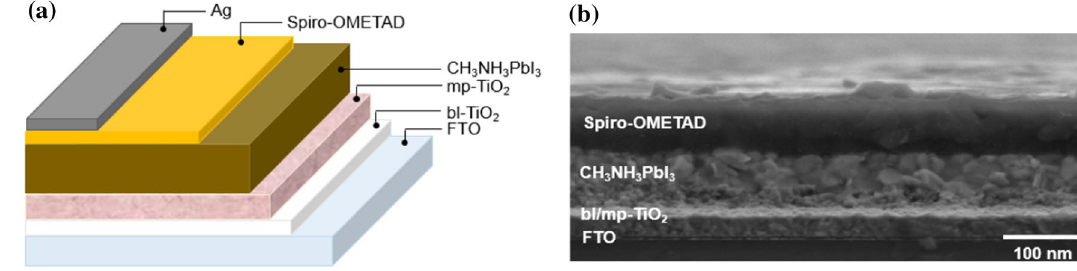
Fig. 1 a Device schematic of perovskite solar cell, and b cross-section FESEM of perovskite solar cells Fig. 2 a Schematic of conven- tional two-step method and delay-deposition procedure of MAI for perovskite film fabrica- tion, and b photographs of PbI 2 , TS-0s, DDTS-5s, DDTS-10s, and DDTS-15s